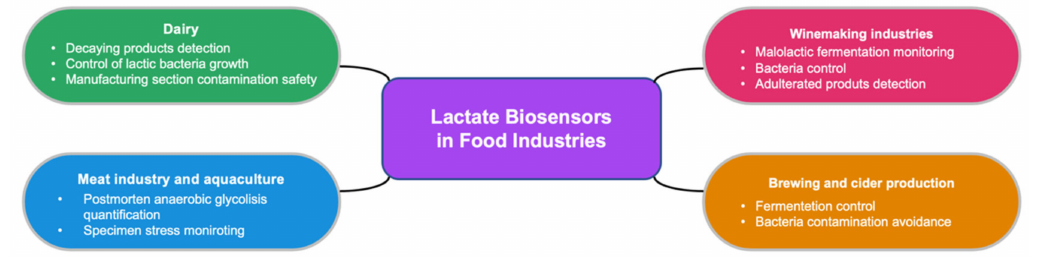
Figure 7. The most eminent applications of lactate biosensors in food